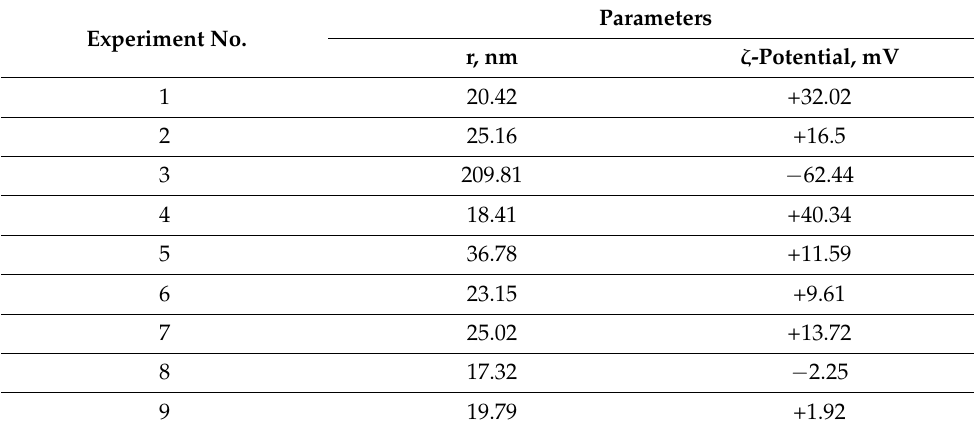
Table 5. Results of optimization of the method of synthesis of Se NPs stabilized with catamine AB. Experiment